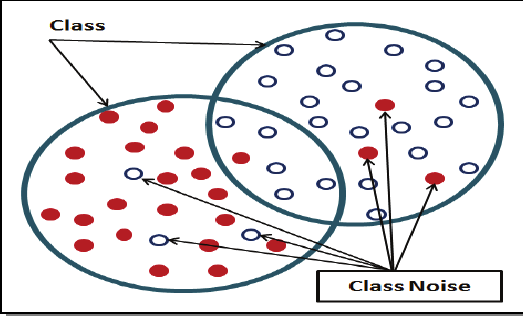
Figure 1. Graphical Representation of Class